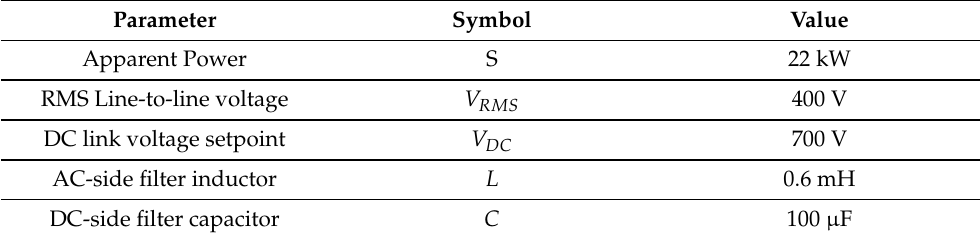
Table 4. AFE rectifier parameters used in the